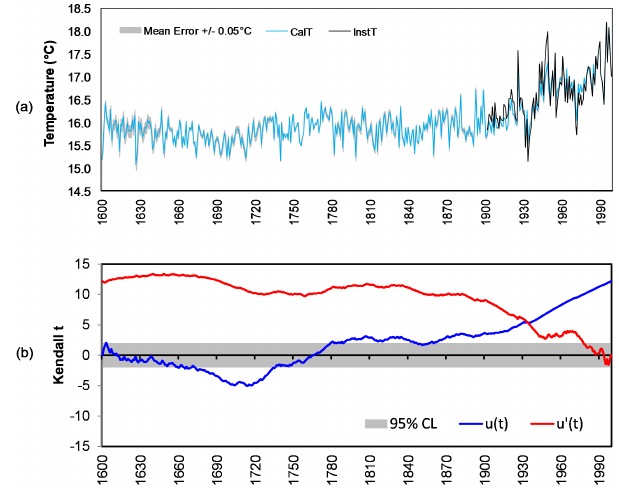
Figure 4. Chronogram of (a) CalT (calibrated annual mean temper- ature) in the period of 1600–1999 and InstT (instrumental series) in the period of 1901–1999. Estimated errors are shaded grey, with a mean error of 0.05 ◦ C. (b) Forward ( u ( t )) and backward ( u (cid:48) ( t )) series of the normalized Kendall t parameter from the progressive Mann–Kendall analysis of CalT. The 95% confidence interval for the no-trend hypothesis in grey